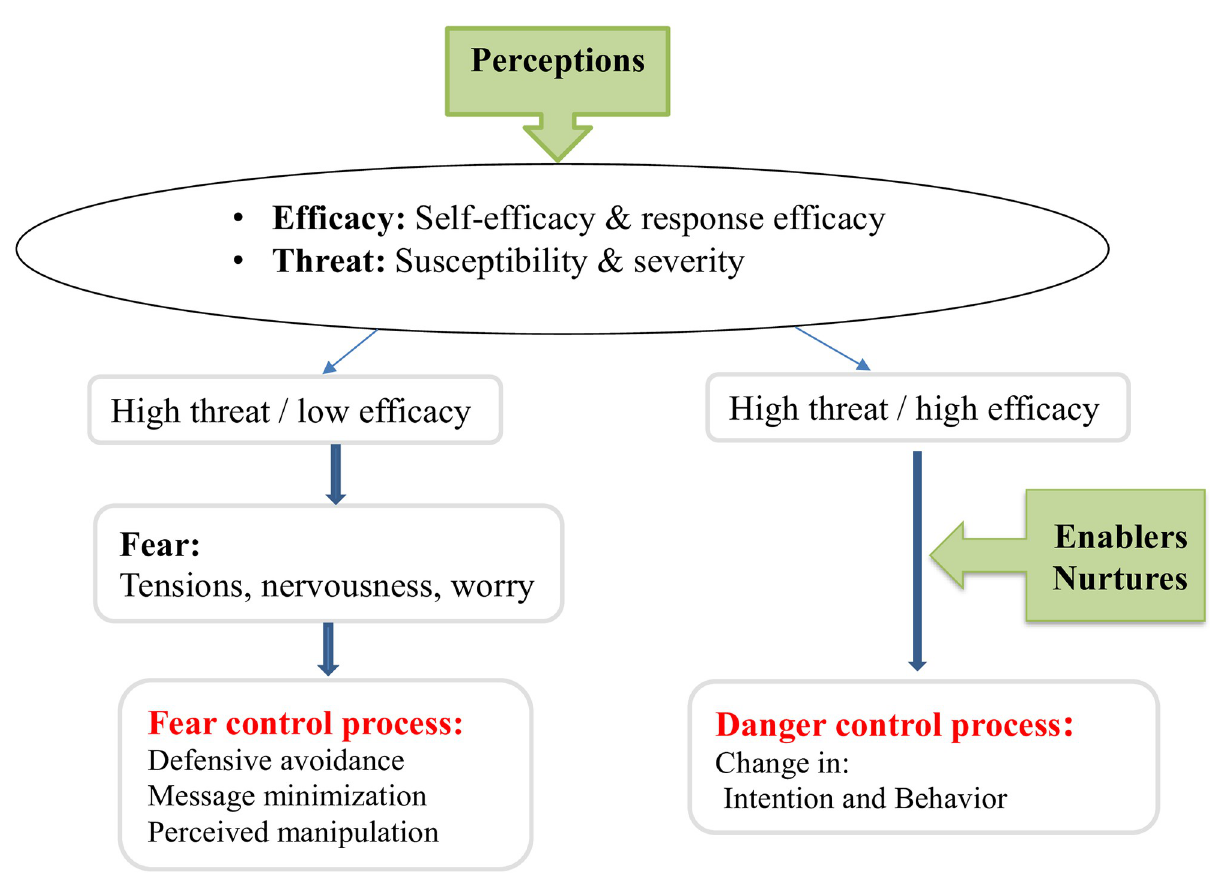
Fig 1. The pattern of PEN-3 and EPPM models integration used in the present